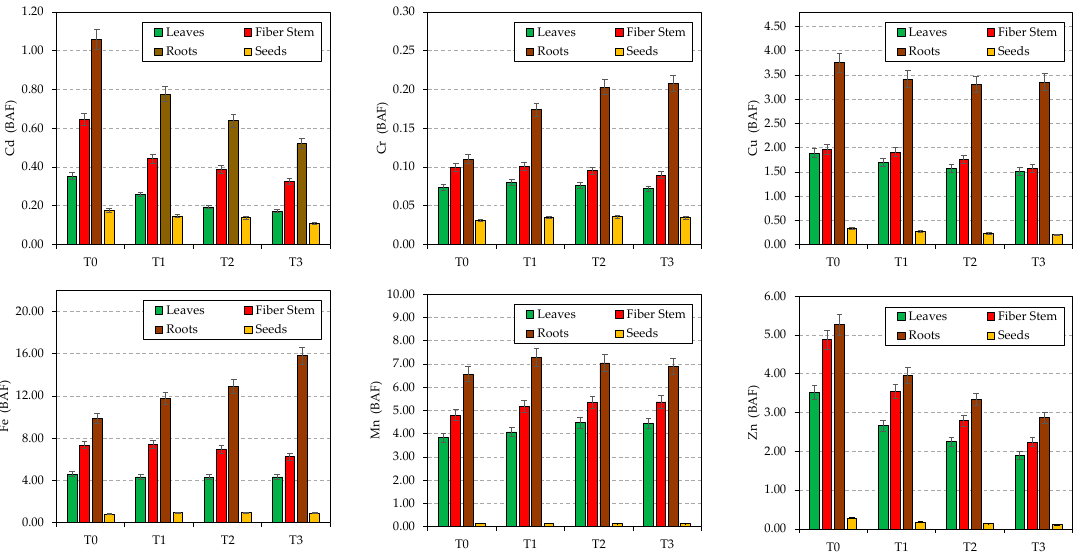
Figure 2. Bioaccumulation factor (BAF) of selected heavy metals in dhaincha ( S. bispinosa ) plant parts grown with different loading rates of sewage sludge (T0, 0% as the control; T1, 5%; T2, 10%; T3, 15%).